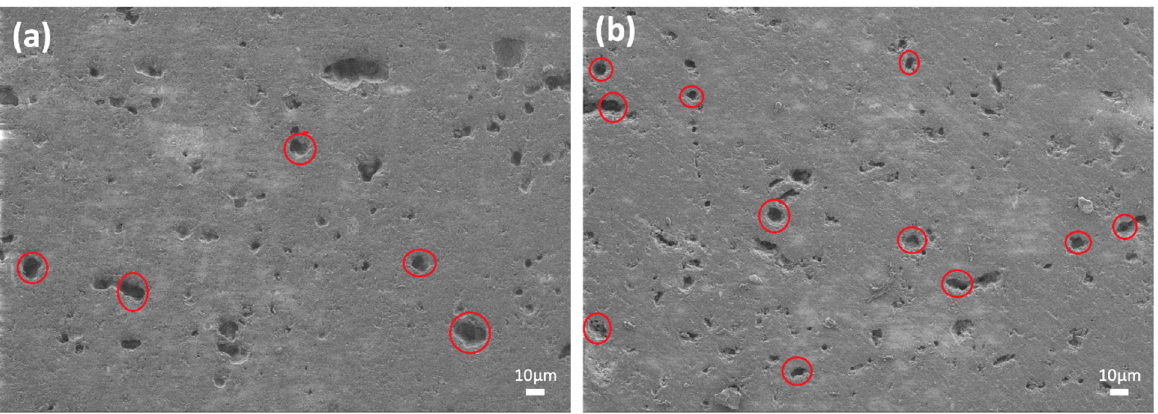
Figure 5. SEM images of the sintered glass-ceramics at 1.00 KX: ( a ) 30Al-O and ( b ) 40Al-O. Figure 4. Optical microscope images of the sintered ceramics: ( a ) 30Al-O, ( b ) 40Al-O, ( c ) 50Al-O, ( d ) 30Zr-Ar, ( e ) 40Zr-Ar, and ( f ) 50Zr-Ar.